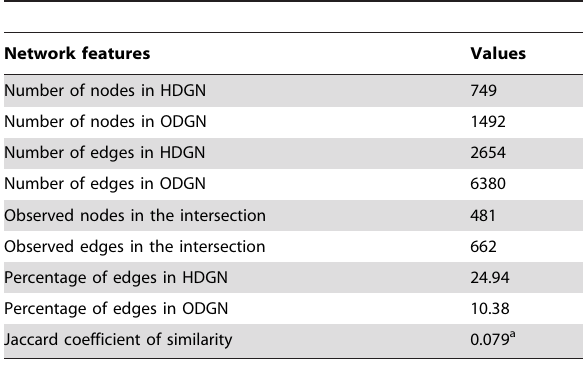
Table 3. Network intersection analysis between HDGN and ODGN.